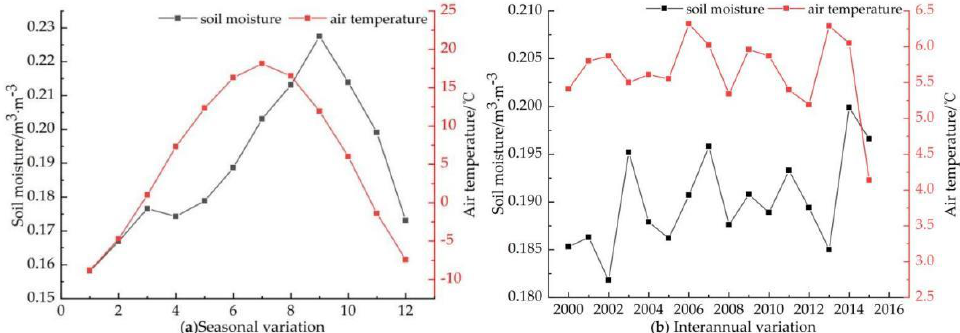
Figure 11. Seasonal and interannual variation of SM and air temperature in the Yellow River Basin, 2000 to 2015: ( a ) Seasonal variation, ( b ) Interannual variation